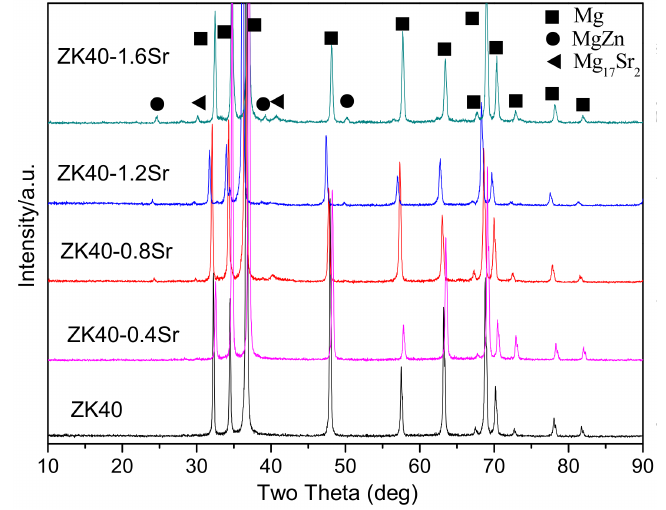
Figure 3. X-ray diffractometer (XRD) patterns of the BDF ZK40-xSr alloys.